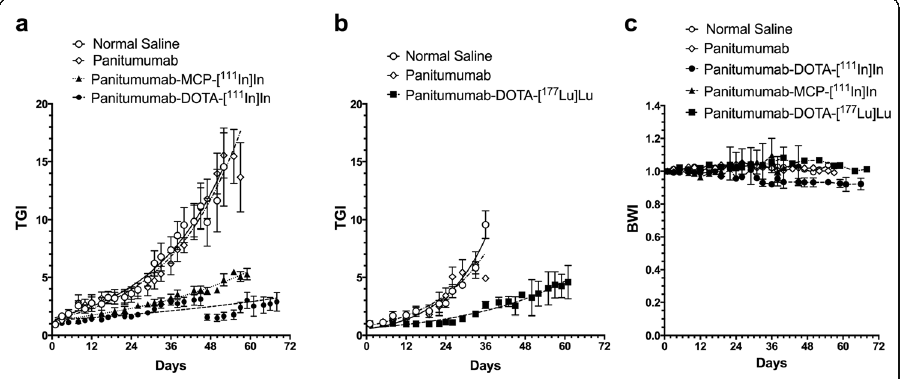
Tumour and normal organ dosimetry The absorbed doses in s.c. PANC-1 tumours after administration of three amounts (10 MBq; 10 μ g; ~ 0.07 nmoles) of panitumumab-DOTA-[ 111 In]In or panitumumab-MCP- [ 111 In]In to NOD/SCID mice were 8.8 ± 3.0 Gy and 2.6 ± 0.3 Gy, respectively (Table 2; P < 0.006). The absorbed dose in the tumour after injection of a single amount (6.0 MBq; 10 μ g) of panitumumab-DOTA-[ 177 Lu]Lu to NRG mice with s.c. PANC-1 xeno- grafts was 11.6 ± 4.9 Gy, which was not significantly different than that for